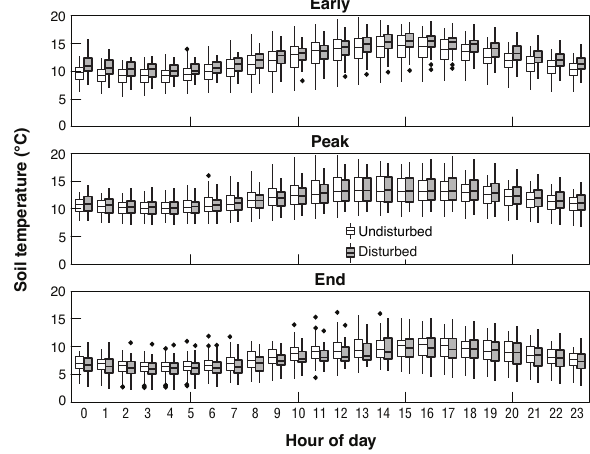
Figure 4. Ensemble average diurnal course of soil temperatures in the disturbed and undisturbed sites throughout the season. Early season: 24 June–4 July; peak season: 5–21 July; end of season: 22– 29 July. Boxes show the 25th and 75th percentiles; dots are the out- liers; horizontal lines are